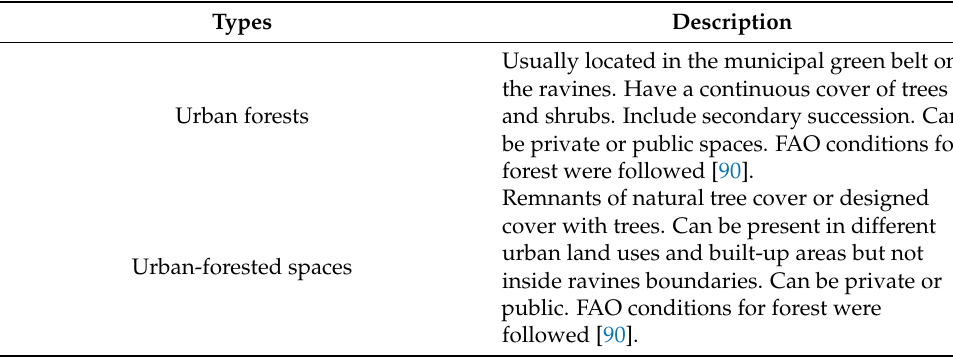
Table 1. Urban green spaces types of Guatemala